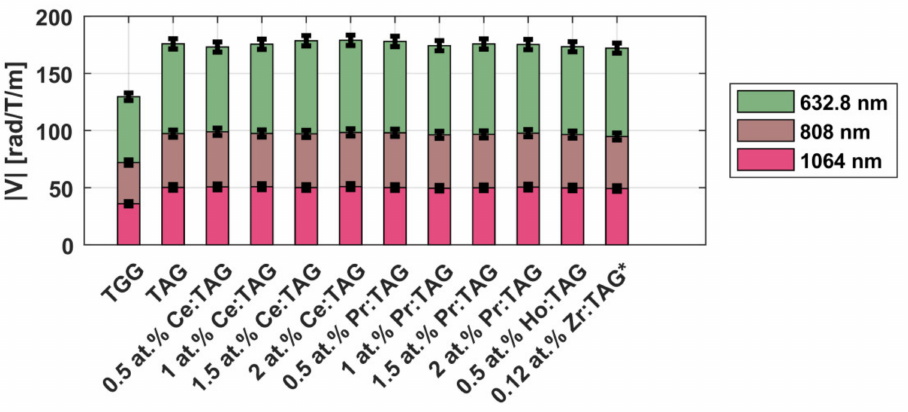
Figure 4. Verdet constant of the TGG and Re:TAG ceramics samples at the wavelengths 1064, 808 and 633 nm [38]. *—unpublished results.